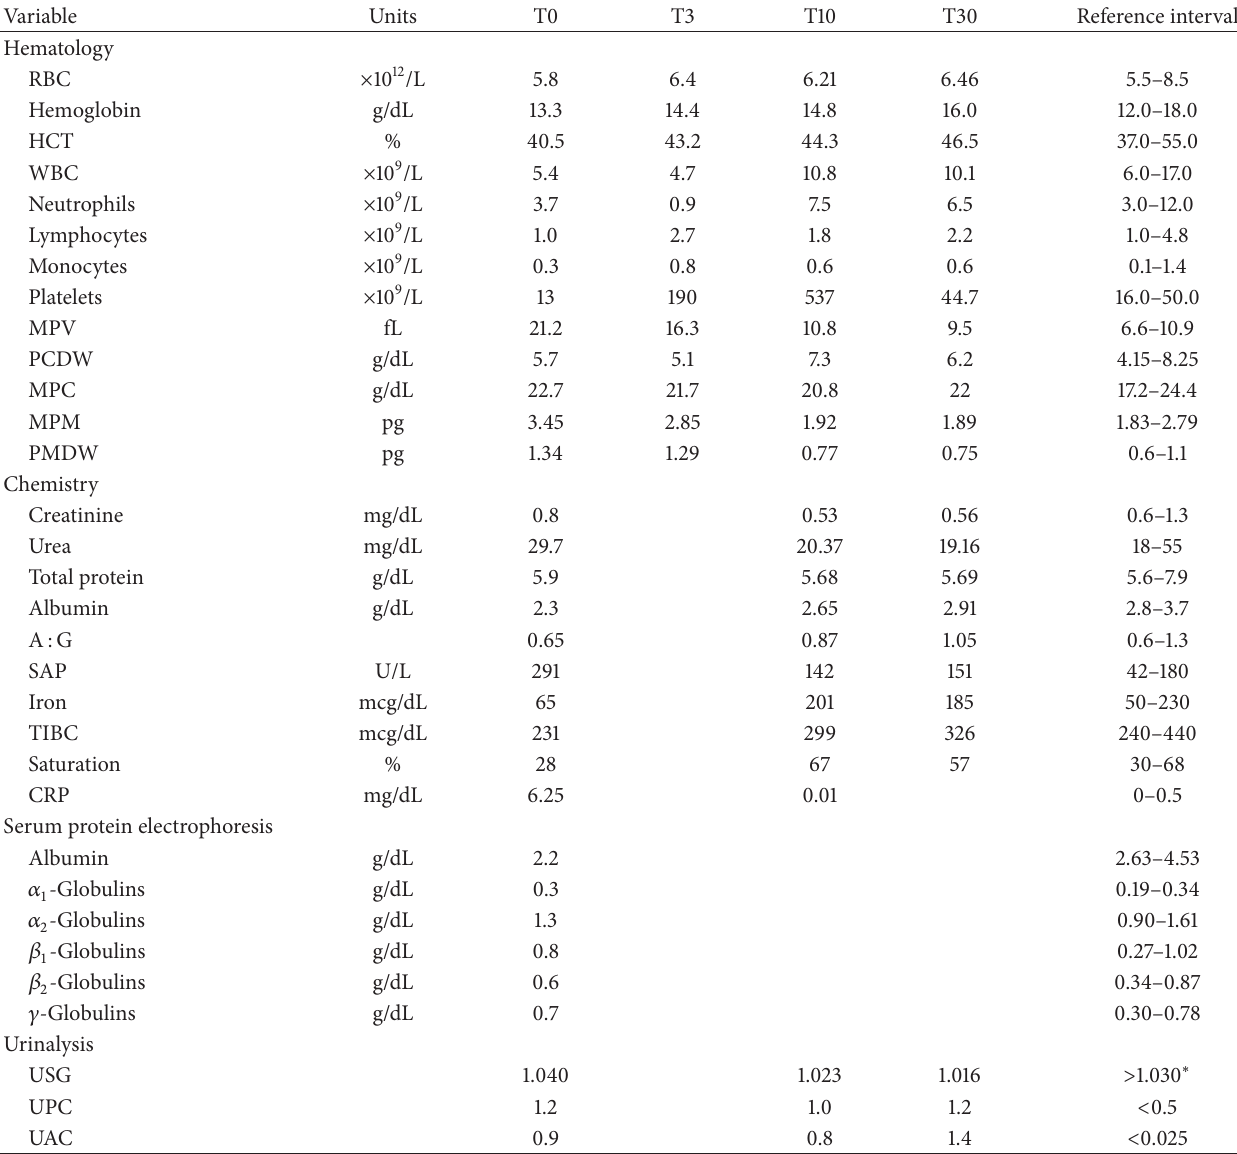
Table 1: Pertinent clinicopathological findings of Case